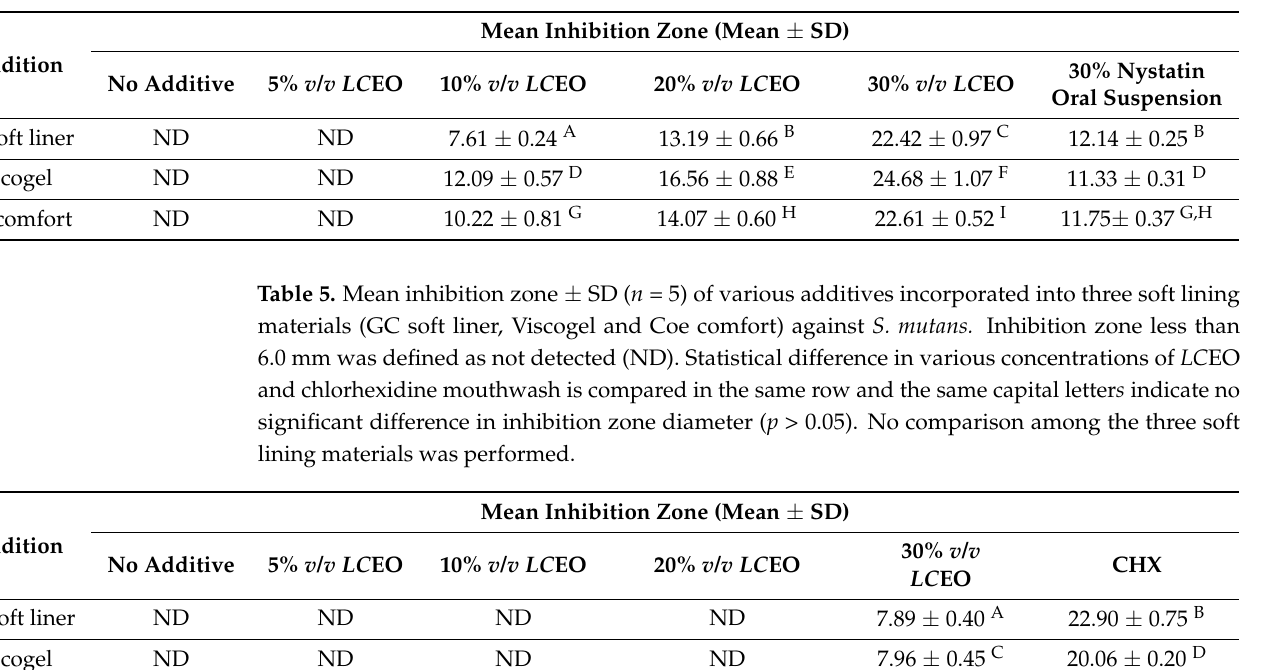
Figure 2 . Inhibition zones of various concentrations of LCEO incorporated into three soft lining materials against S. mutans ( upper row ) and C. albicans ( lower row ). All agar well diffusion plates composed of GC soft liner ( left ), Viscogel ( middle ) and Coe comfort ( right ) incorporated with 5, 10, 20 and 30% v / v LCEO, positive control (5% v / v of 2% chlorhexidine gluconate (CHX) for S. mutans and 30% v / v nystatin oral suspension (NYS) for C. albicans) and negative control (soft lining material without additive). Table 4. Mean inhibition zone ± SD ( n = 5) of various additives incorporated into three soft lining materials (GC soft liner, Viscogel and Coe comfort) against C. albicans . Inhibition zone less than 6.0 mm was defined as not detected (ND). The statistical difference in various concentrations of LC EO and nystatin oral suspension is compared in the same row and the same capital letters indicate no significant difference in inhibition zone diameter ( p > 0.05). No comparison among the three soft lining materials was performed.